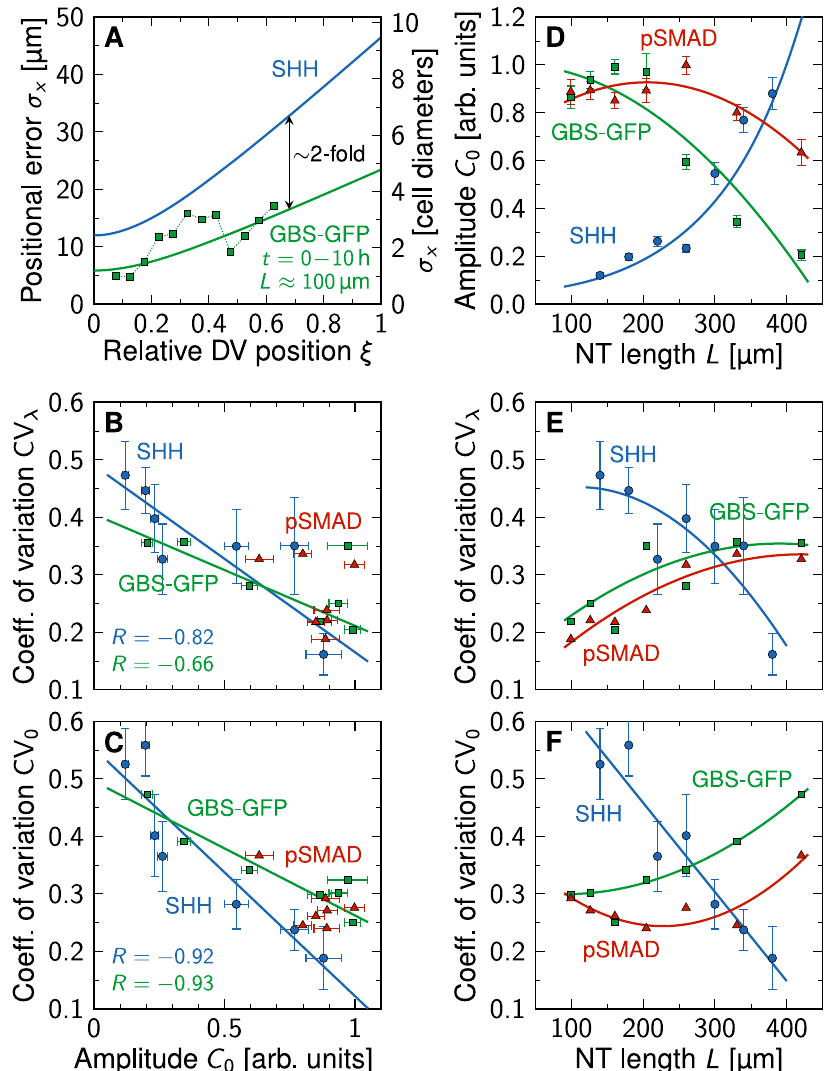
Fig. 7 Technical limitations in measuring morphogen gradients. A With the reported variability, the SHH (blue) gradients would be about twice as imprecise as its readout GBS-GFP (green). The fi rst developmental timepoint (0 – 10 h) of the GBS-GFP data (symbols) was reproduced from 9 ; solid lines represent Eq. (10) with GBS-GFP and SHH parameters inferred from 9,12 (Table 1). B , C Gradient variability is anti-correlated with the amplitude (Pearson correlation coef fi cient R ≪ 0), hinting at a potential technical limitation in the fl uorescence intensity measurements. D The reported amplitudes of the SHH gradient increases, while the amplitudes of the GBS-GFP and pSMAD gradients decrease as the NT expands. E , F The reported gradient variabilities show the opposite trend. Solid lines are polynomial least-squares fi ts as listed in Table 1. Data in ( B – F ) are presented as mean values ± SEM from n = 31, 63, 22, 36, 11, 12, 6 (SHH, blue), n = 30, 62, 69, 17, 42, 32, 21 (GBS-GFP, green), n = 24, 40, 46, 19, 55, 33, 19 (pSMAD, red) measurements per bin, reproduced from 9,12 . Source data are provided as a Source Data fi